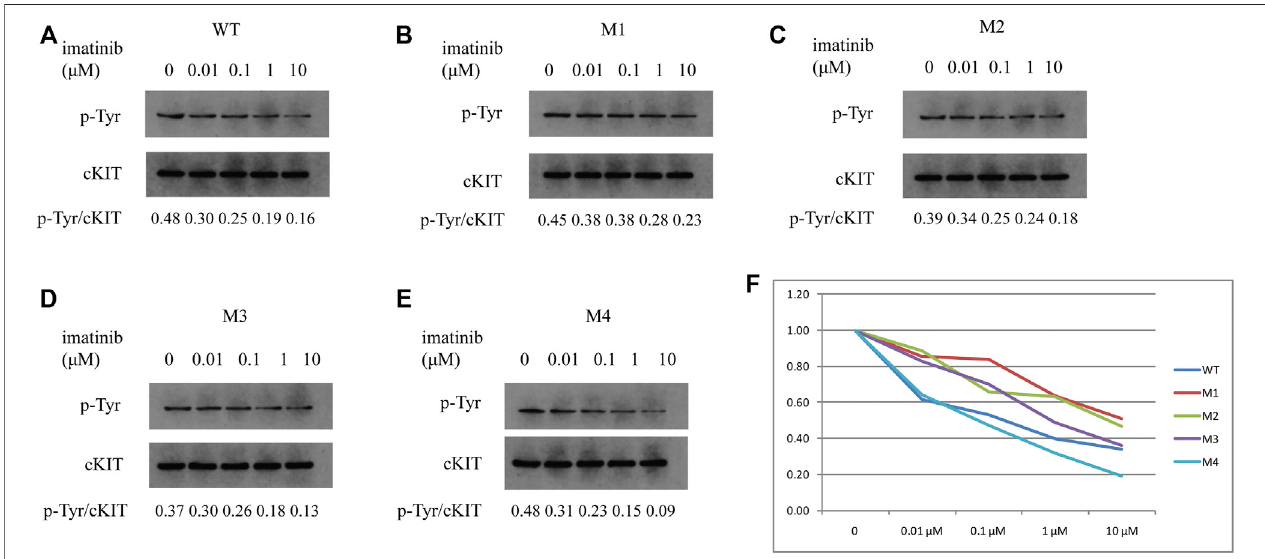
FIGURE 5 | Phosphotyrosine levels were analyzed in SK-MEL-28 cells transfected with various plasmids using Western blotting. p-Tyr and cKIT levels were indicated in cells transfected by wild-type plasmid (A) , M1 (B) , M2 (C) , M3 (D) , and M4 (E) , respectively, which were treated with imatinib at concentrations of 0, 0.01, 0.1, 1, and 10 μ M. The ratios of p-Tyr to cKIT are shown at the bottom of each panel. As shown in the line chart (F) , the values of p-Tyr to cKIT were compared to the individual value at 0 μ M for each plasmid at the individual concentration of imatinib. p-Tyr denotes phosphotyrosine.